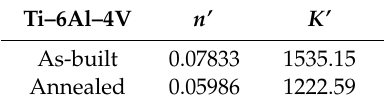
Figure 11. The cyclic Ramberg–Osgood model fit of the measured data for ( a ) as-built SLM Ti–6Al–4V and ( b ) annealed SLM Ti–6Al–4V. Table 5. Parameters of the cyclic Ramberg–Osgood model for the SLM Ti – 6Al – 4V.